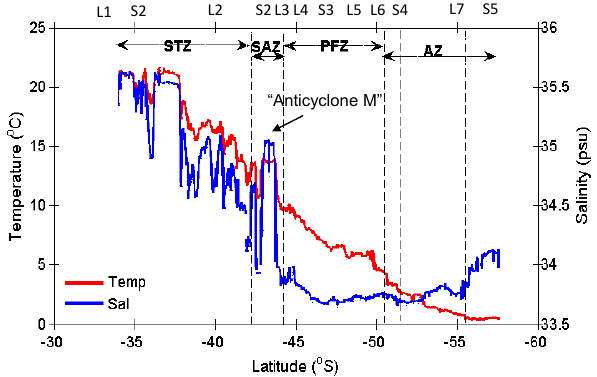
Figure 2. Zonal description of the regions during the cruise (Sub Tropical Zone (STZ), Sub Antarctic Zone (SAZ), Polar Front Zone (PFZ) and Antarctic Zone (AZ). Surface temperature (red line) and surface salinity (blue line) with latitude along the cruise track measured by onboard continuous thermosalinograph. Sampling station identifiers are indicated above the plot. The position of Anticyclone M is indicated by an increase in temperature and salinity in the SAZ.